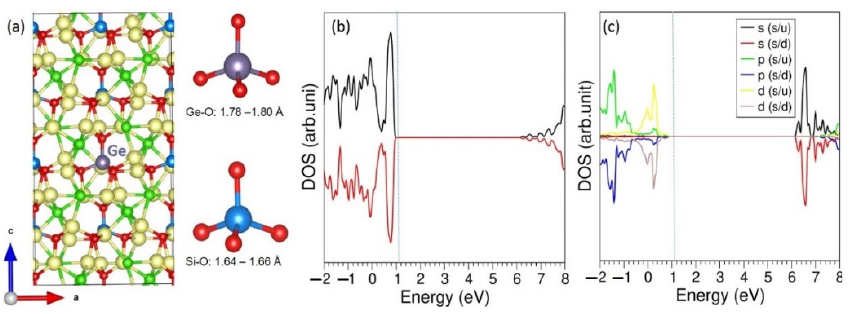
Figure 6. Solution energies of tetravalent dopants on the Si site.